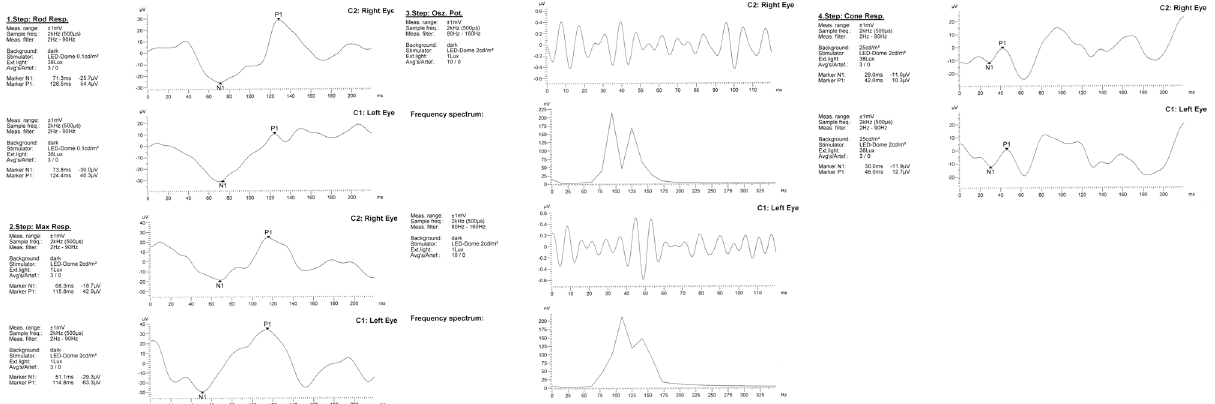
Figure 6: Electroretinography